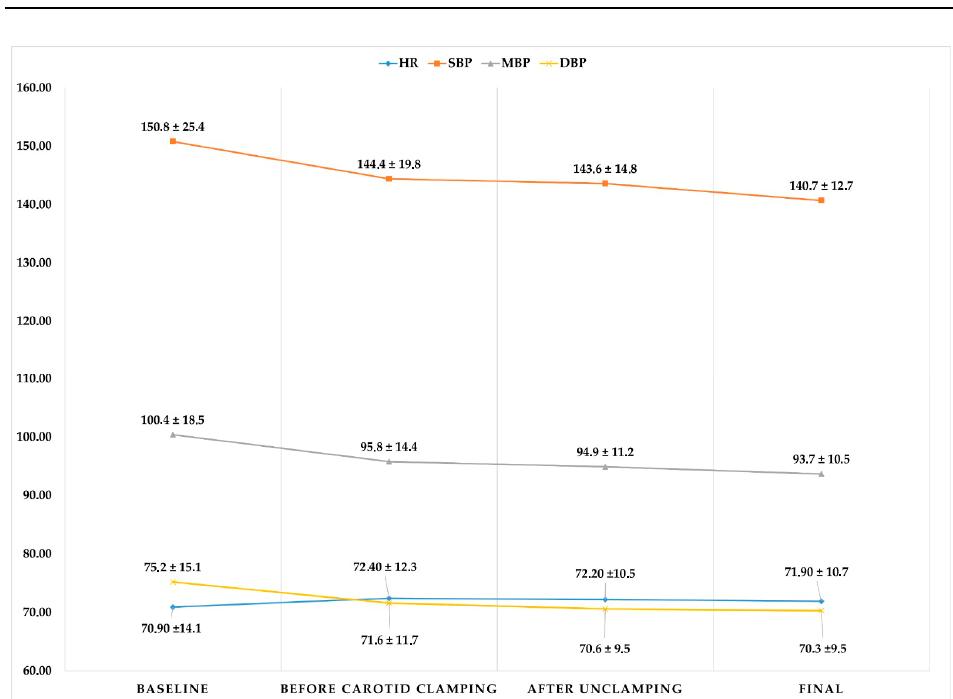
Figure 3. Hemodynamic variability during the intervention expressed as heart rate and blood pressure values. HR, heart rate; SBP, systolic blood pressure; MBP, median blood pressure; DBP, diastolic blood pressure. Data are expressed as mean and standard